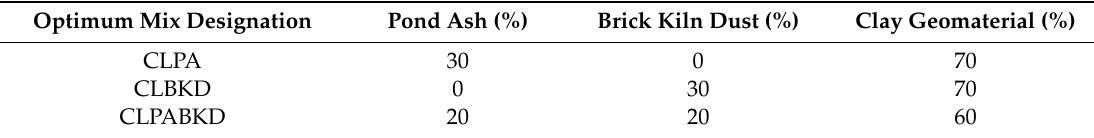
Table 7. Notation of the mix proportions for the optimized